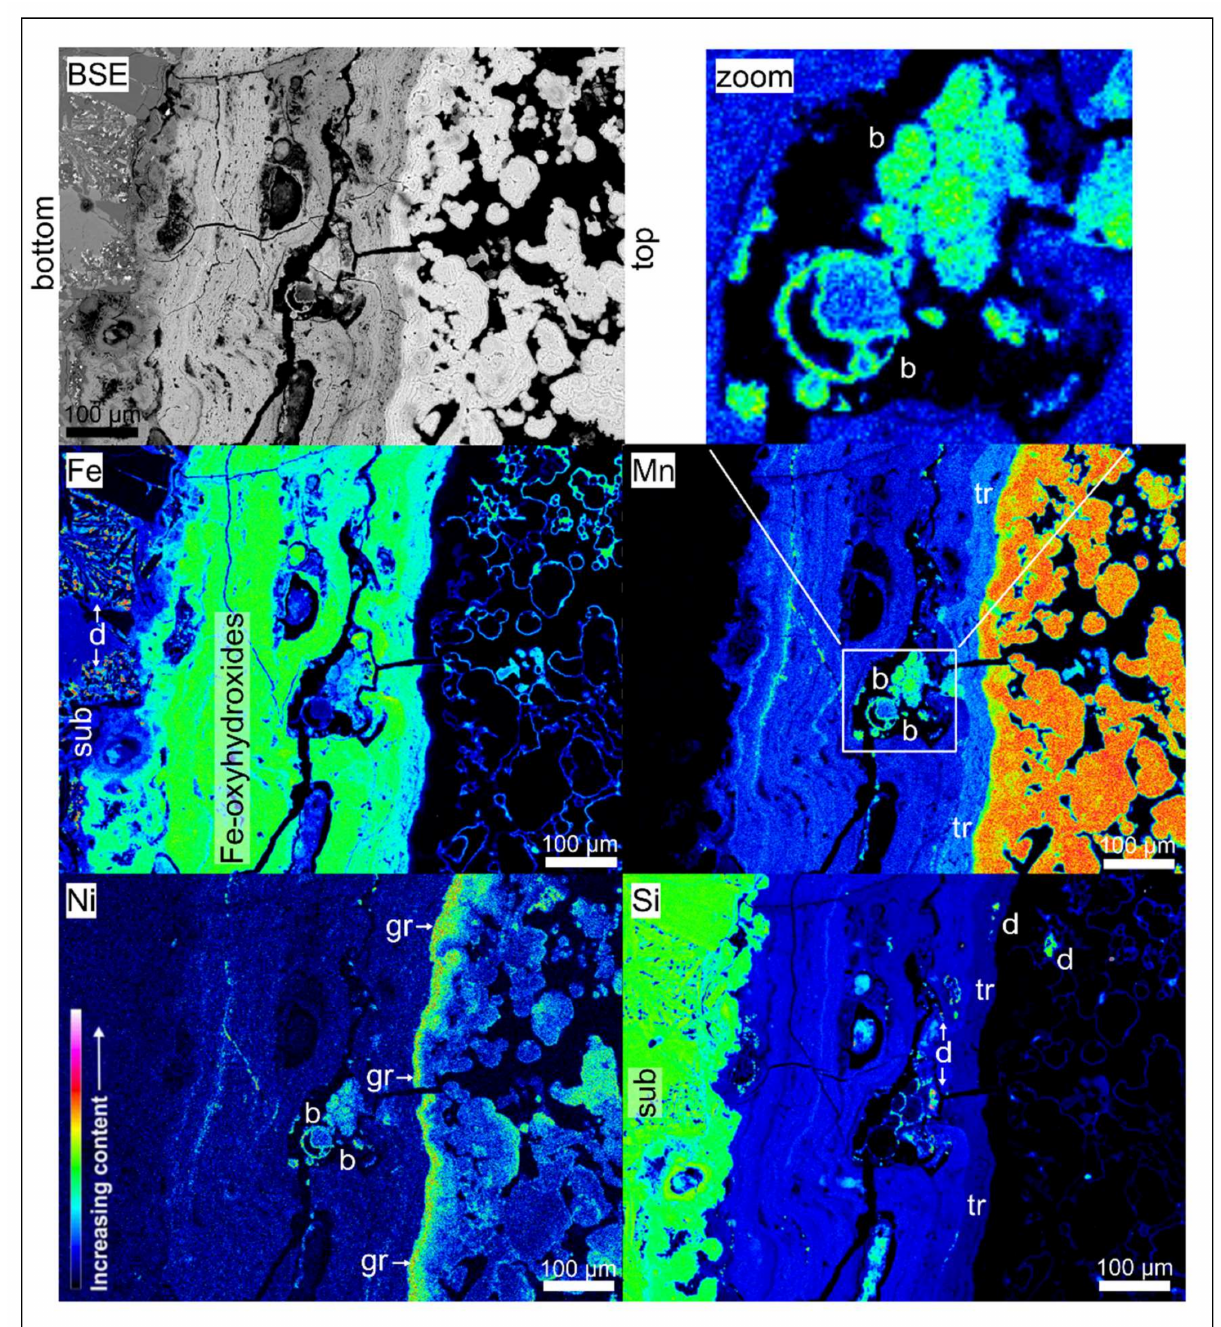
Figure 7. The representative EPMA mapping of thin SIO0000D1 crust sample (substrate-colloforms transition zone). Crust bottom and top indicated by BSE photography. Visible remnants of substrate and well developed alteration layer composed of Fe-dominated oxyhydroxides in ‘iddingsite’. Middle part of Mn image (white rectangle) shows rounded biogenic remnants covered by thin layer of Mn- oxyhydroxides: sub—substrate remnants, d—debris (mostly Fe-Ti oxides and silicates), b—biogenic and biomorphic features, tr—transitional zone/layer, gr—growth direction based on visible Ni